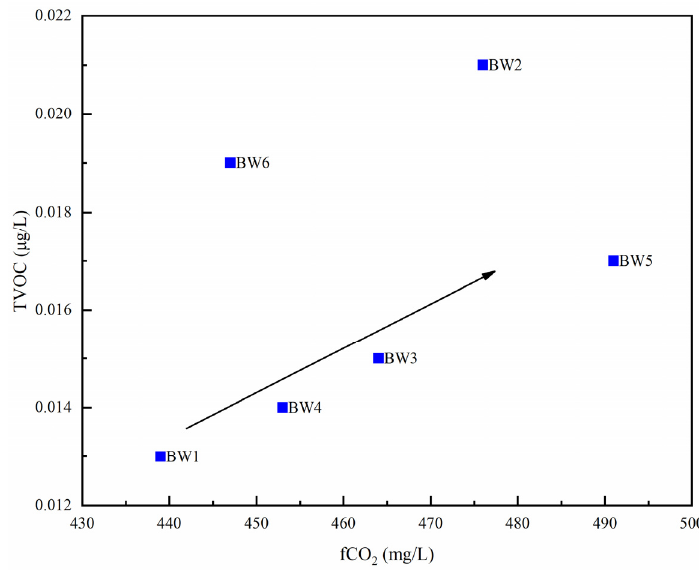
Figure 6. Relationship between TVOC and free CO 2 in the Boiling-Wells.